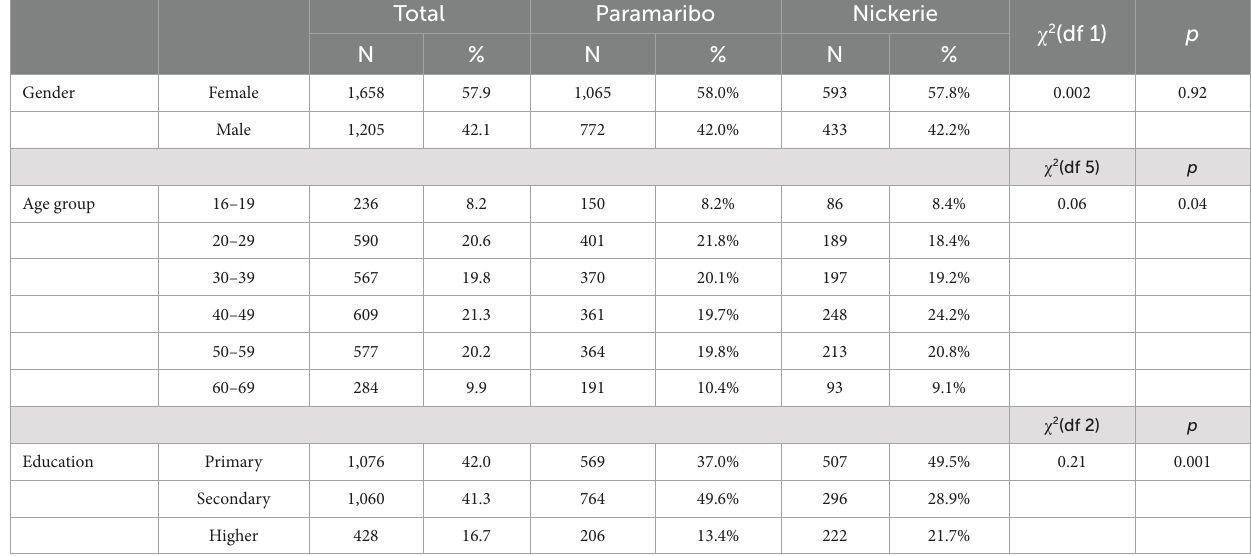
TABLE 2 Demographic data for all respondents and for the urban and rural